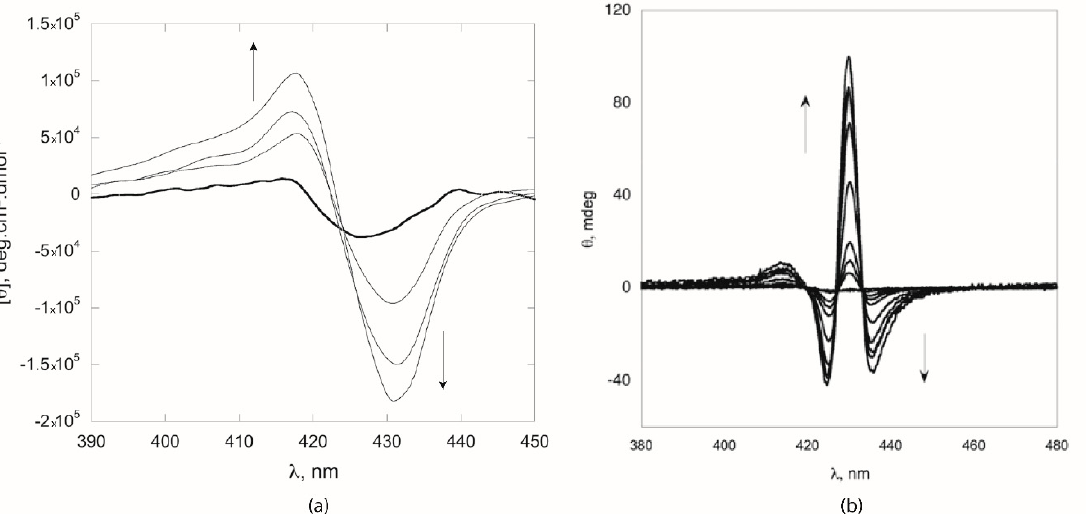
Figure 5. CD spectroscopic features of steroid-functionalized porphyrins 6 and 7 : ( a ) porphyrin 6 in dimethyl acetamide (DMAC) / H 2 O (84 / 16 v : v ) mixtures upon increasing porphyrin concentration from